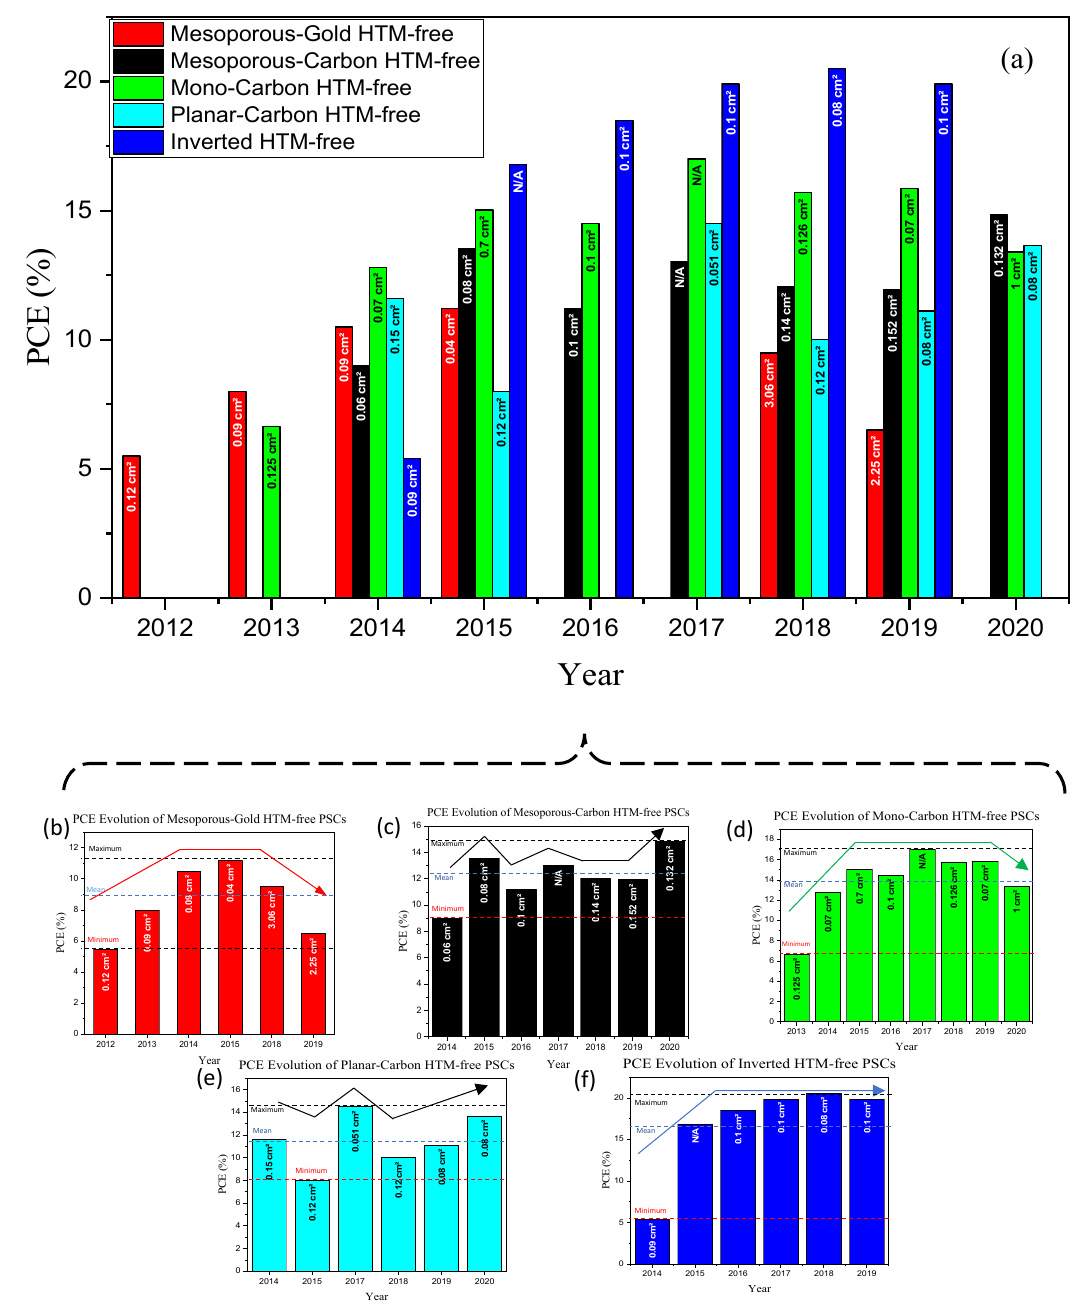
Figure 1. ( a ) Evolution of PCE (power conversion efficiency) of different types of HTM-free PSCs; Gold (Au) counter electrode (CE)-based, mesoporous carbon-based (meso-carbon HTM-free), monolithic carbon-based (mono-carbon HTM-free), planar carbon CE-based (planar-carbon HTM-free) and the inverted HTM-free PSC. The active area of the fabricated devices is mentioned in the bar-charts (N/A is denoted for area values that are not mentioned in the published file). The data are obtained starting from 2012 (when HTM-free PSC was first introduced, with a gold counter electrode). The individual progress of the different architectures can also be observed in ( b – f ).